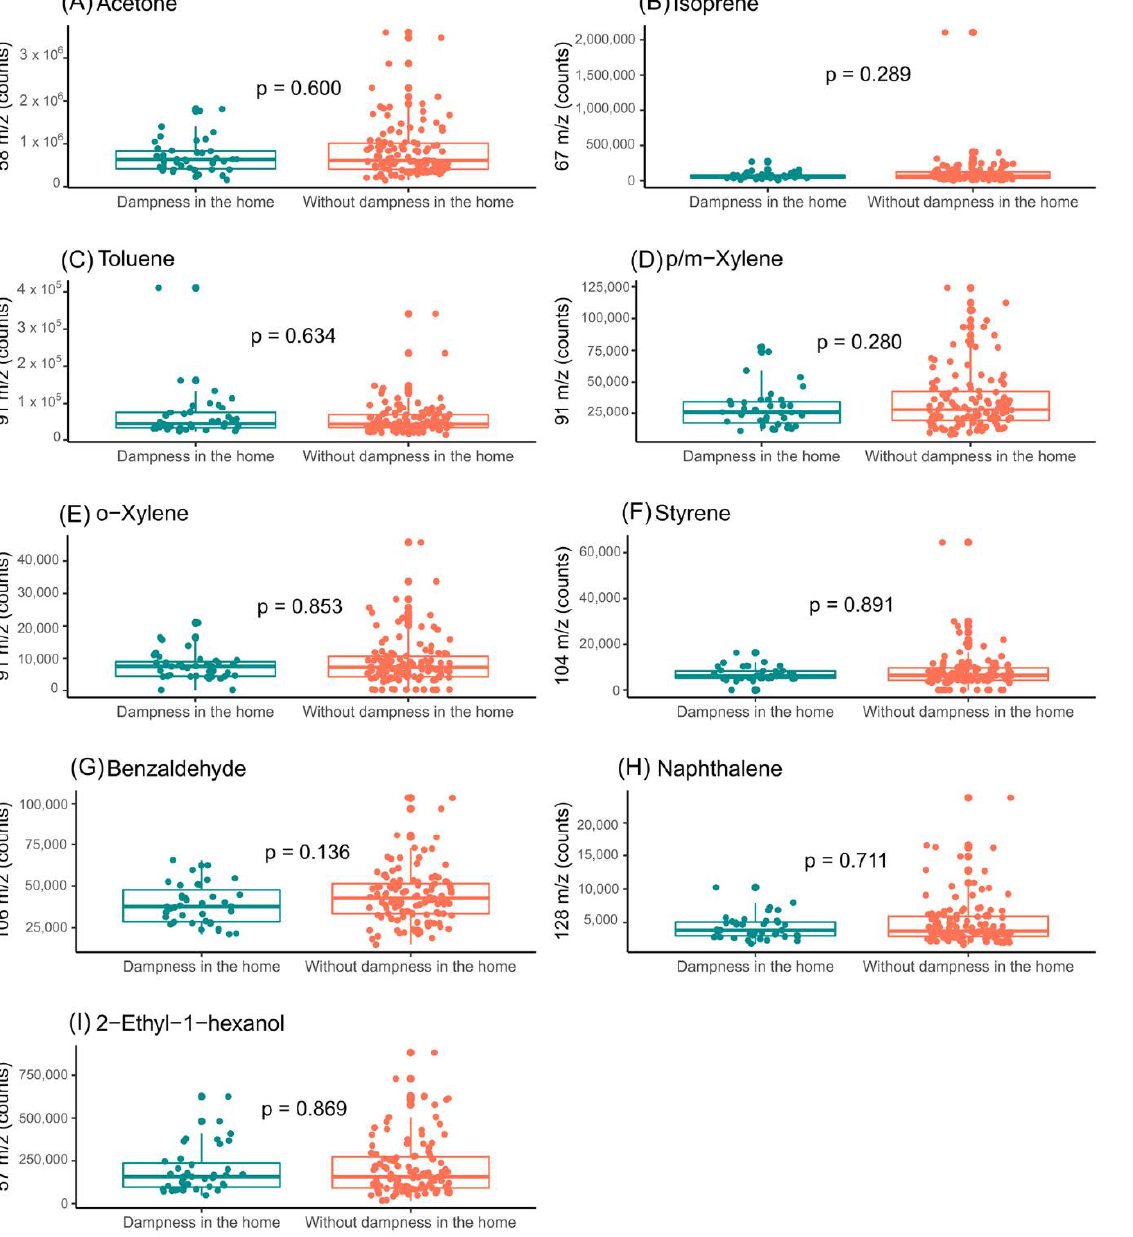
Figure 5. Assessment of influence of indoor-dampness exposure on the levels of the features selected in exhaled breath from boys. ( A ) Impact of indoor-dampness exposure on levels of acetone ( m/z = 58); ( B ) impact of indoor-dampness exposure on levels of isoprene ( m/z = 67); ( C ) impact of indoor-dampness exposure on levels of toluene ( m/z = 91); ( D ) impact of indoor-dampness exposure on levels of p/m-xylene ( m/z = 91); ( E ) impact of indoor-dampness exposure on levels of o-xylene ( m/z = 91); ( F ) impact of indoor-dampness exposure on levels of styrene ( m/z = 104); ( G ) impact of indoor-dampness exposure on levels of benzaldehyde (m/z = 106); ( H ) impact of indoor-dampness exposure on levels of naphthalene ( m/z = 128); and ( I ) impact of indoor-dampness exposure on levels of 2-ethyl-1-hexanol ( m/z = 57) in exhaled breath of boys.